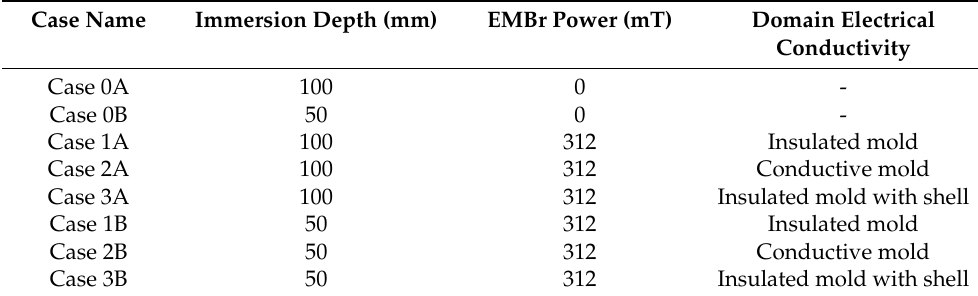
Table 1. Outline of the simulated